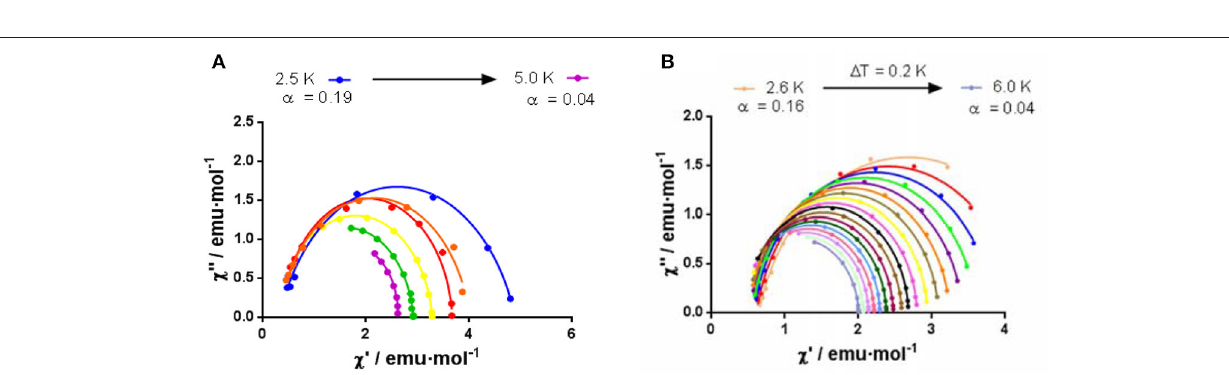
Frontiers in Chemistry |